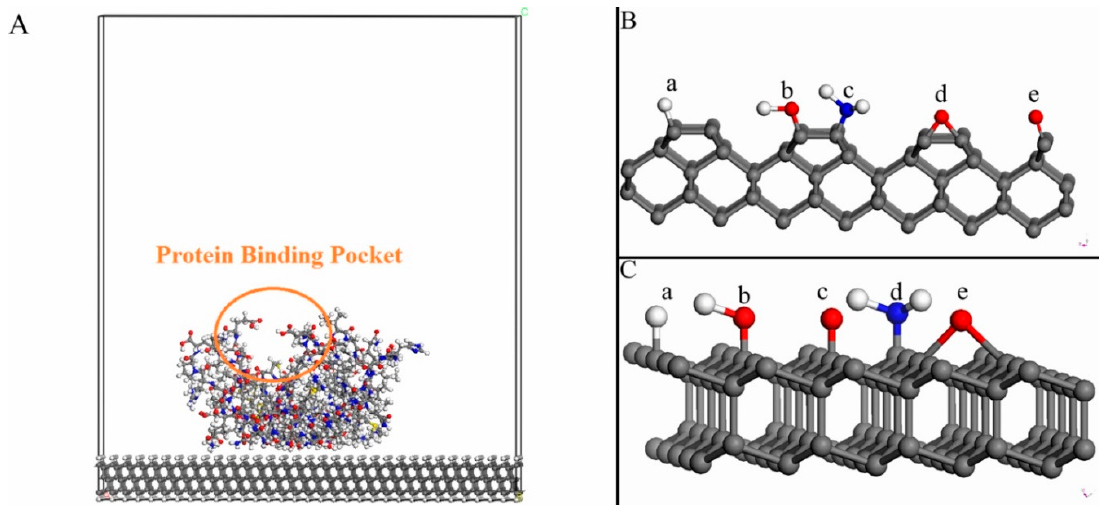
Figure 1. ( A ) Model demonstrating a 2x1-reconstructed diamond (111) surface that is to 100% terminated with H atoms and thereafter attached to a Vascular Endothelial Growth Factor (VEGF) molecule. The orientation of the biomolecule is such that the protein binding pocket is on top and far away from the surface. ( B ) Five different termination species adsorbed onto a 2x1-reconstructed diamond (100) surface: (a) H, (b) OH, (c) NH 2 , (d) O bridge and (e) O ontop . ( C ) Five different termination species that are adsorbed to a diamond (111) surface: (a) H, (b) OH, (c) O ontop , (d) NH 2 and (e) O bridge .